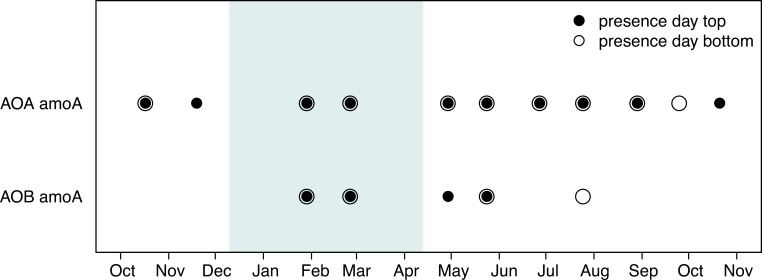
Presence of archaeal and bacterial amoA gene fragment at both depths during the day.Presence is assumed when PCR amplicon was obtained. The period where the lake was covered by ice is depicted by a light blue rectangle. AOA ammonia-oxidizing archaea; AOB ammonia-oxidizing bacteria.